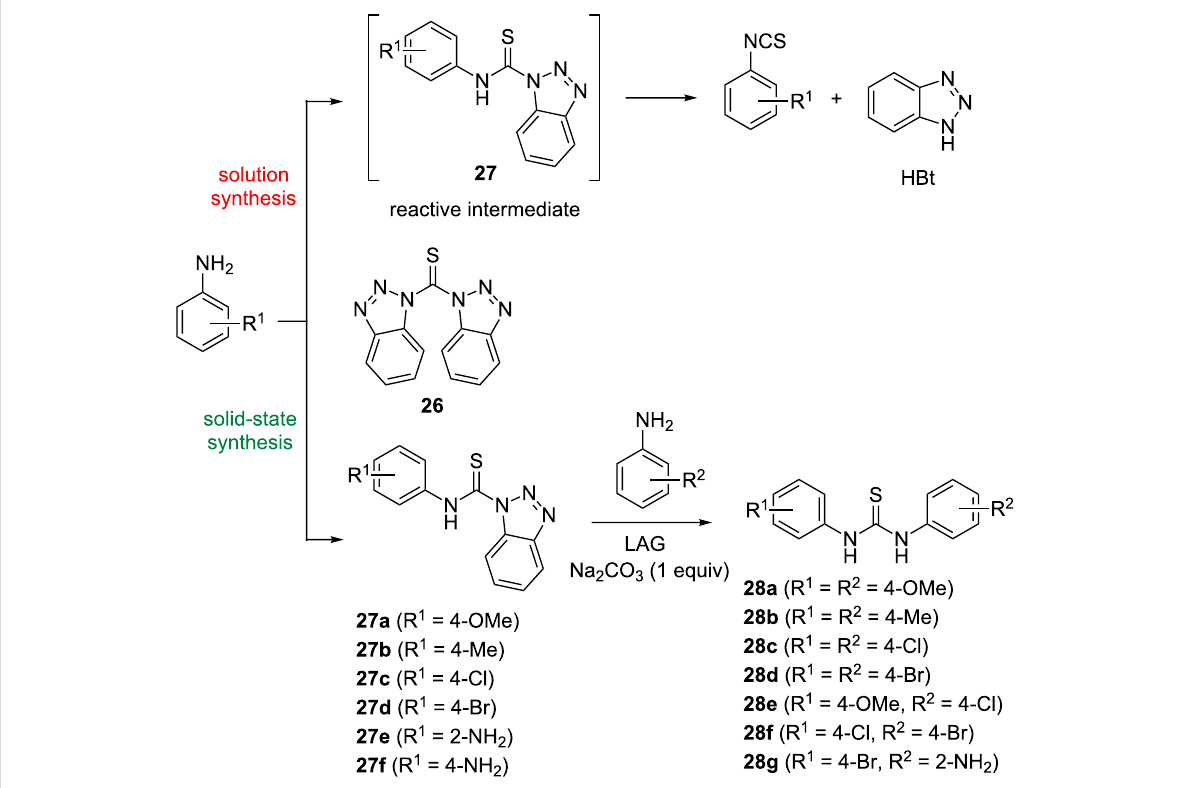
Scheme 9: In solution, aromatic N -thiocarbamoyl benzotriazoles 27 are unstable and decompose to isothiocyanates and benzotriazole (HBt). Mechanochemical solvent-free synthesis yields 27a – f as bench-stable solids, that are readily converted to thioureas 28a – g